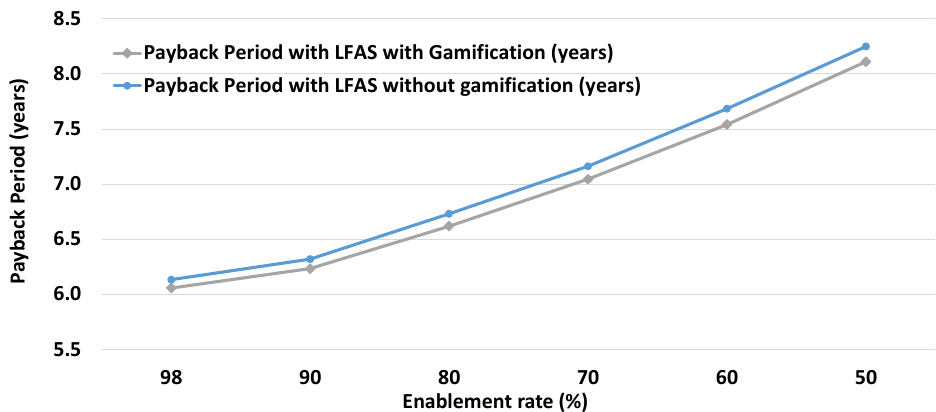
Figure 9. The payback period of the VPP project with and without gamification at different levels of enablement rate (%).